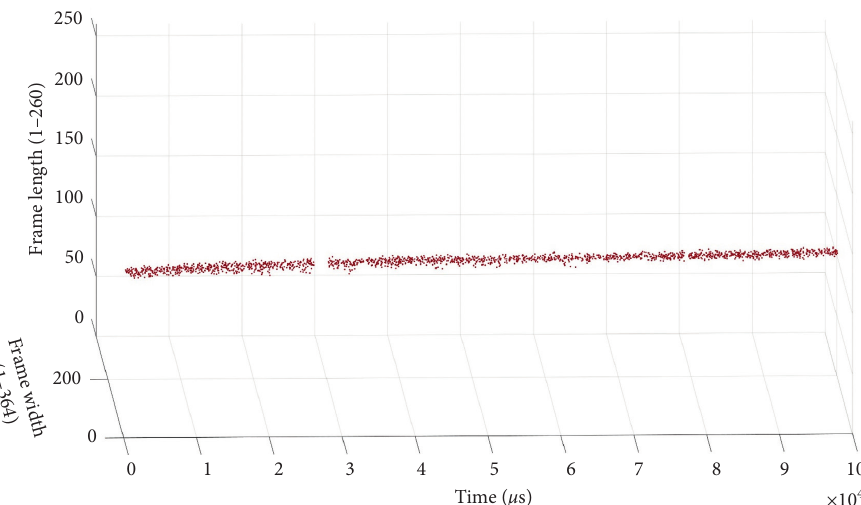
Figure 4: Object tracking effect diagram, the red part is the event stream of the object, every red dot is an event of the object, and events cluster shows trajectory of the